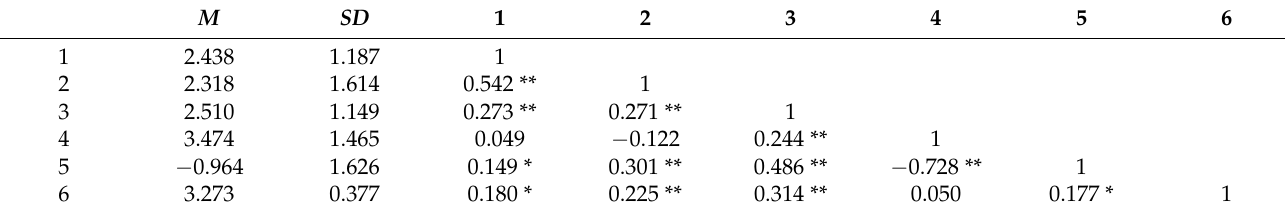
Table 3. Descriptive statistics and correlation matrix for all variables ( n =